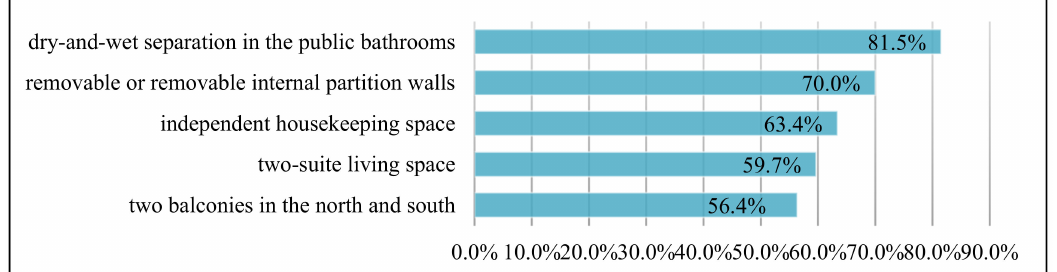
Figure 5. Optimization of indoor